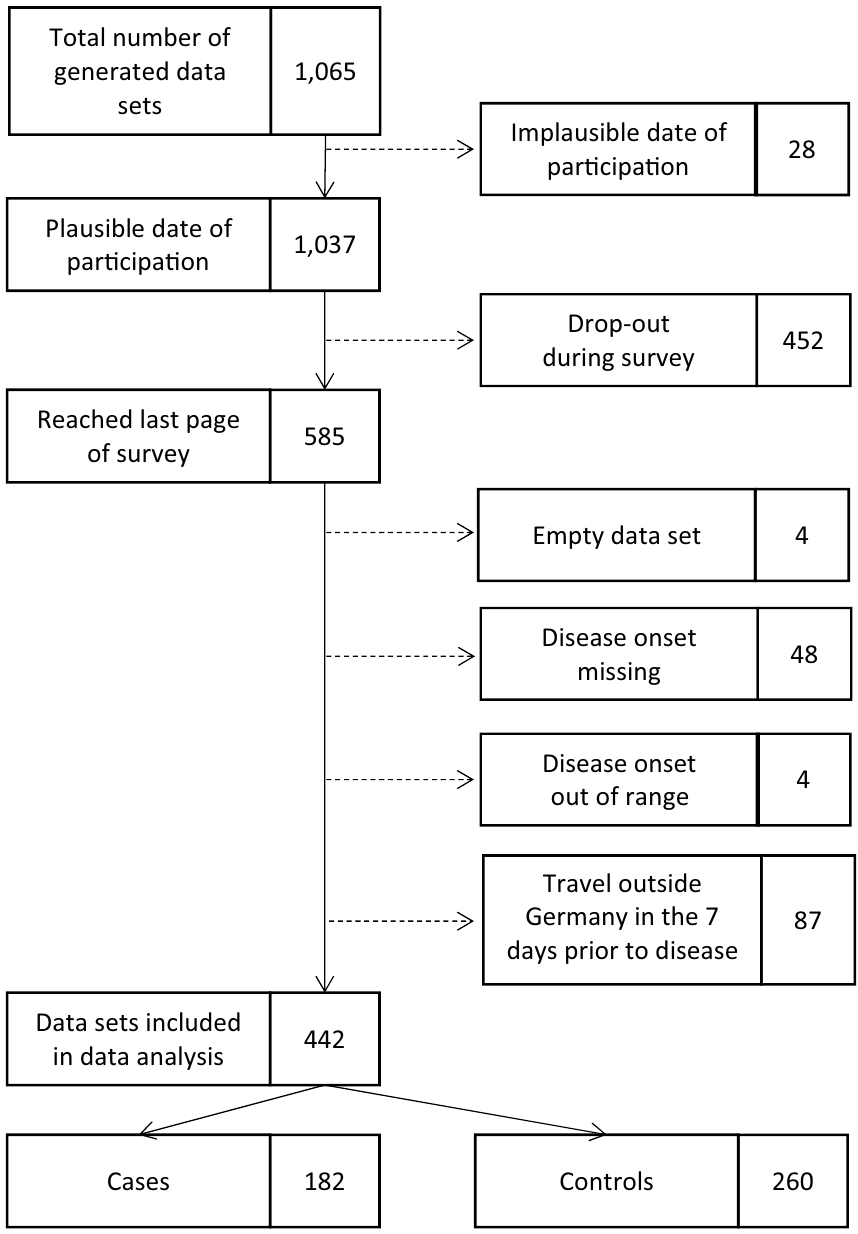
Figure 2. Criteria for inclusion and exclusion of questionnaire data sets in study analysis (number of data sets in boxes on the right